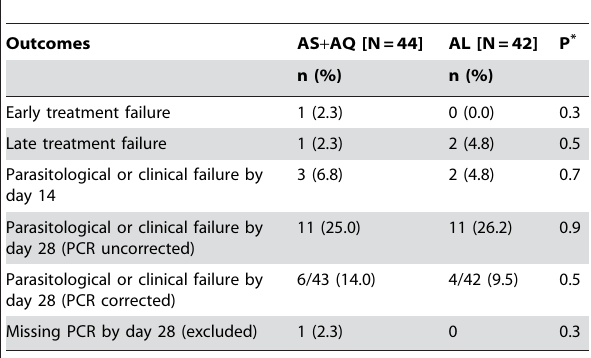
Table 5. Distribution of solicited adverse events during the 7- day post treatment period.